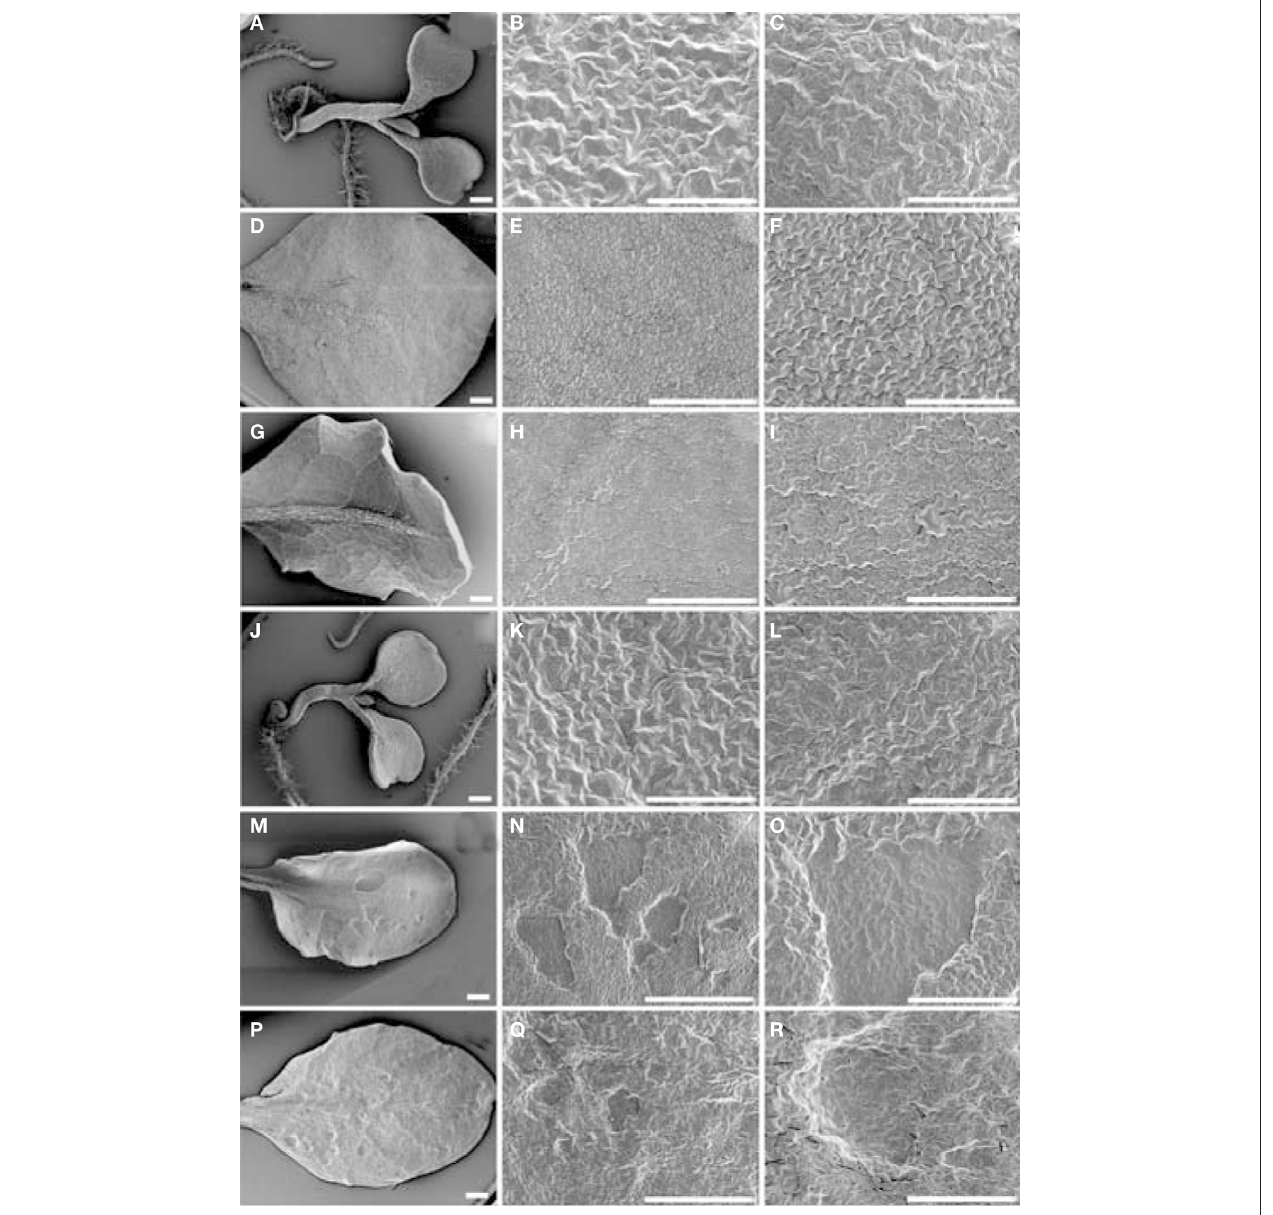
FIgURe 6 | Scanning electron microscopy analysis. Cotyledons and leaves of one-week-old wild-type (A–C) and sns-D (J–L) seedlings, and 5-week-old wild-type (D–I) and sns-D (M–R) plants were analyzed. Adaxial sides of cotyledons (B,K) or leaves (D,e,F,M,N,O) and abaxial sides of cotyledons (C,L) or leaves (g,H,I,P,Q,R) are shown. Bars in (A,D,e,g,H,J,M,N,P, Q) are 500 μm and in (B,C,F,I,K,L,O,R) are